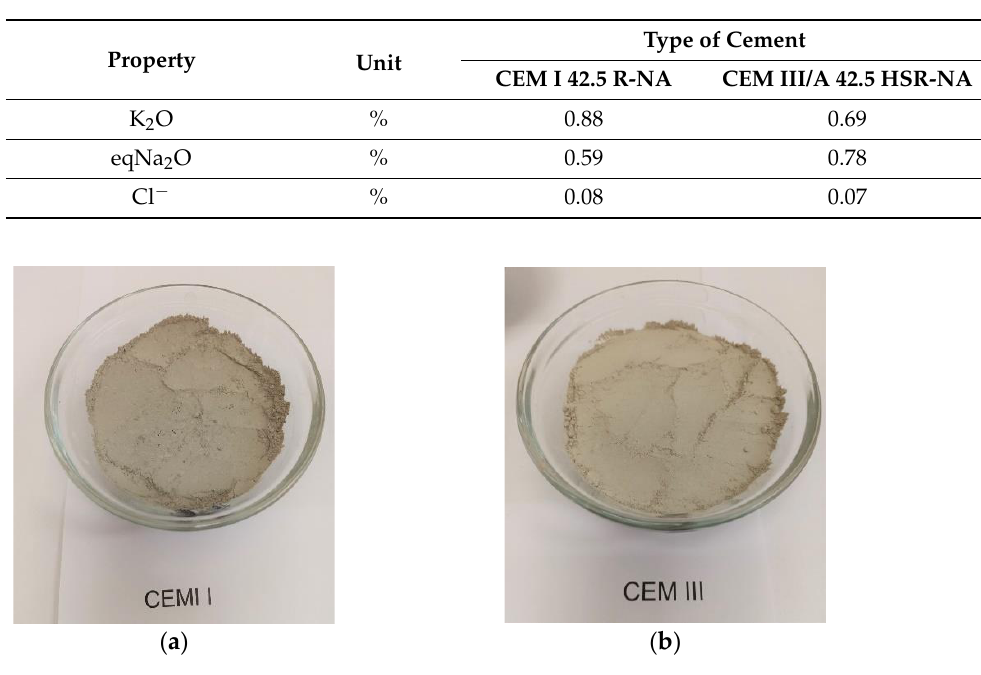
Table 2. Requirements for the concrete pavement for traffic categories KR5 — KR7. Properties of Concrete Pavement